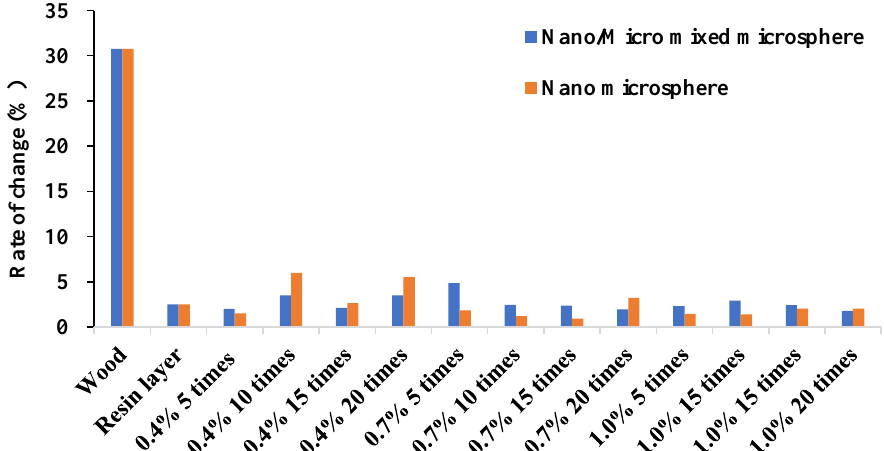
Figure 6. The rate of change of contact angle with different treating conditions.